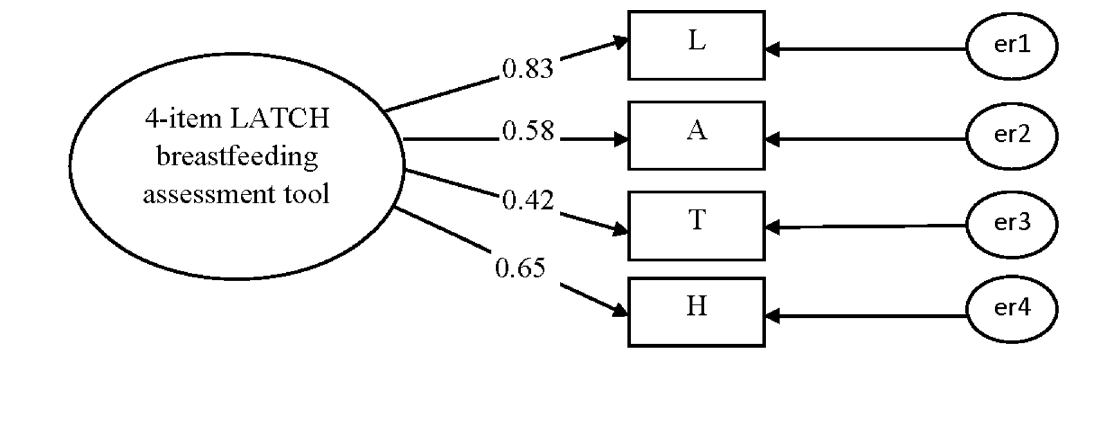
Fig 2. Confirmatory factor analysis for the 4-item LATCH breastfeeding assessment tool vaginally delivered women (n = 335). Fit indices: GFI=0.995; AGFI=0.976; IFI=0.995; TLI=0.985; CFI=0.995; RMSEA=0.044.